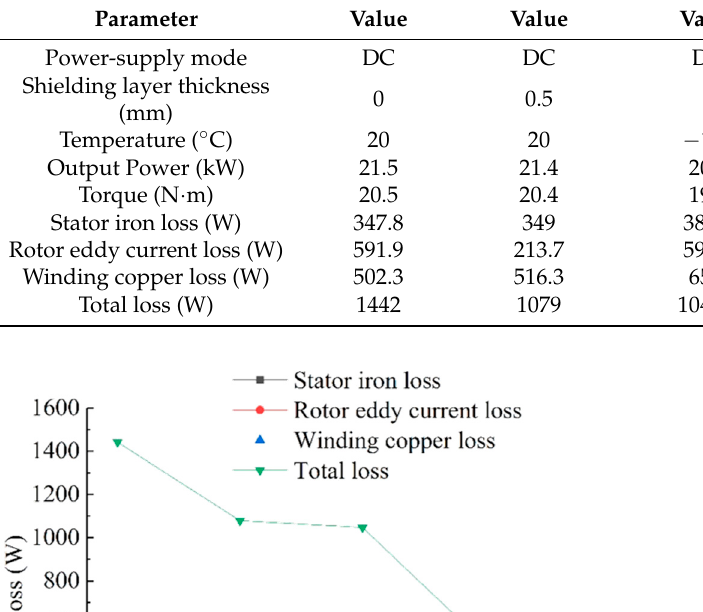
Table 3. Motor-loss data with and without shielding layer at different temperatures.